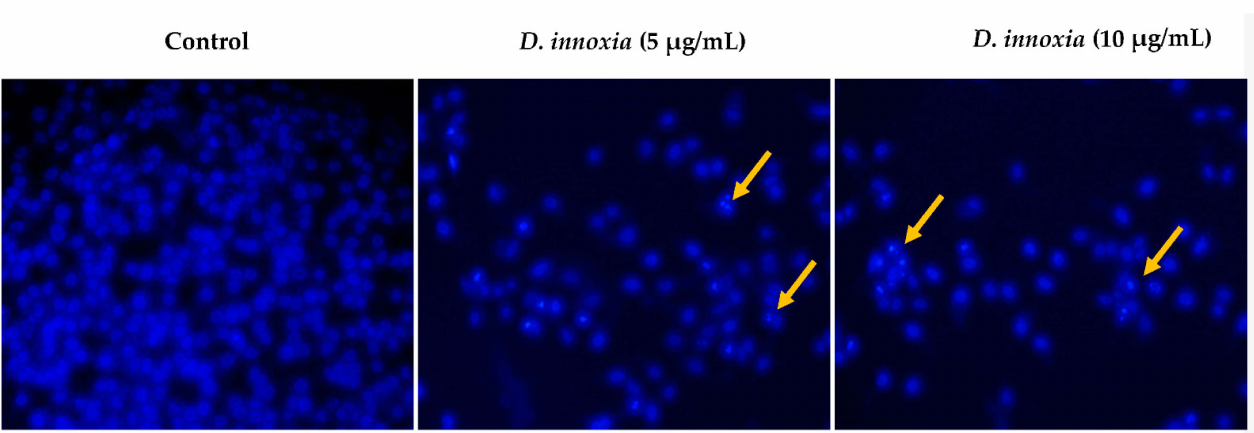
Figure 5. Efficacy of D. innoxia in inducing apoptosis in LoVo cells. The cells were stained with Hoechst dye for nuclear morphology after treatments with D. innoxia ethanolic extract and fluorescent images were obtained. Characteristics of apoptosis, such as nuclear derangement, are observed in LoVo treated cells (arrows) compared to control